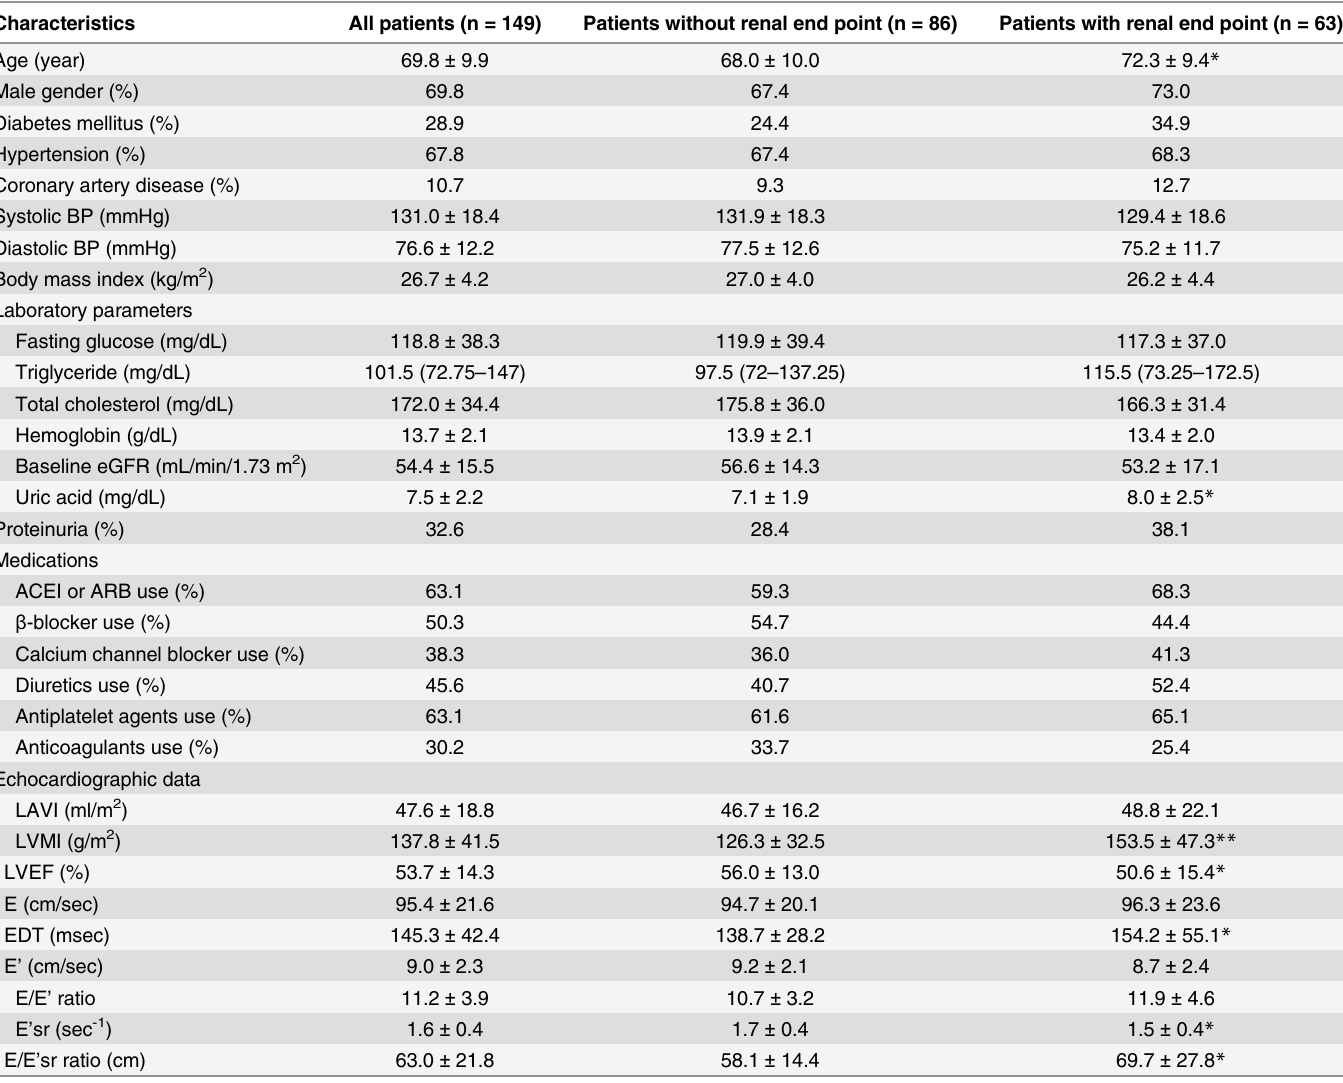
Table 1. Comparison of baseline characteristics between patients with and without renal end point of ≧ 25% decline in eGFR.